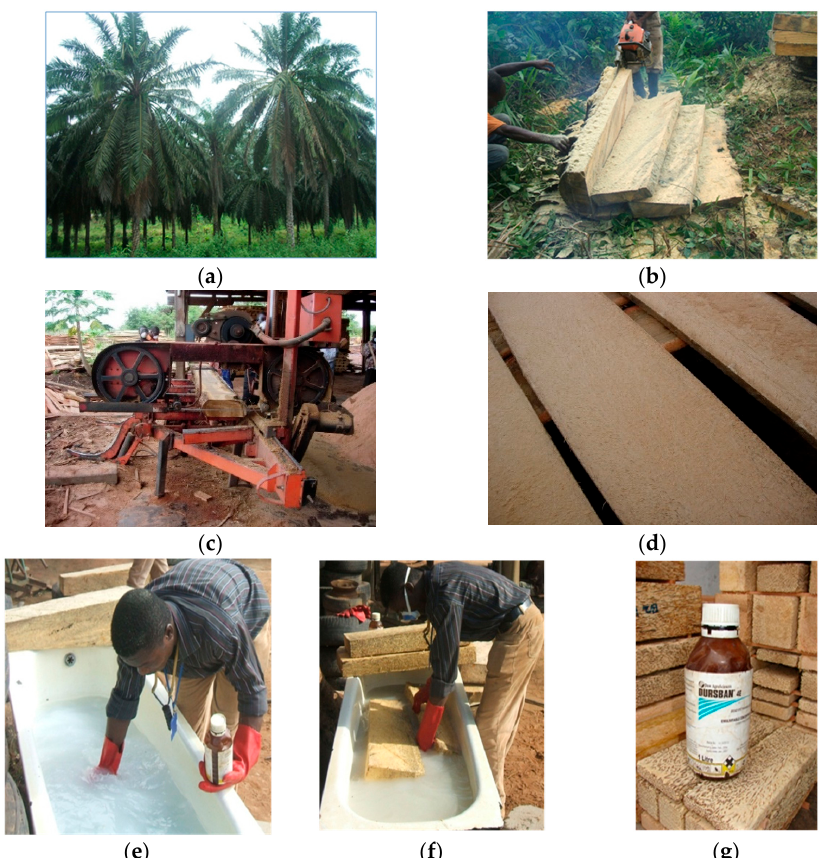
Figure 1. Preparation of study specimens. ( a ). Oil palm plantation; ( b ). Converting oil palm logs into beams; ( c ). Wood-Mizer converting beams into boards; ( d ). Oil palm lumber; ( e ). Adding Dursban into water; ( f ). Immersion of oil palm lumber into preservative; ( g ). Dursban 4E. The prepared test specimens were cut into dimensions of 300 mm × 100 mm × 40 mm (Figure 2). They were separately staked in a clean, environment-controlled room with a temperature of 25 ± 2 °C and relative humidity of 62 ± 2% for an eighteen (18)-week ob- servation period. Pictures were taken at the end of each of the seven days using a Samsung Galaxy S9+, camera version 10.0.03.31.